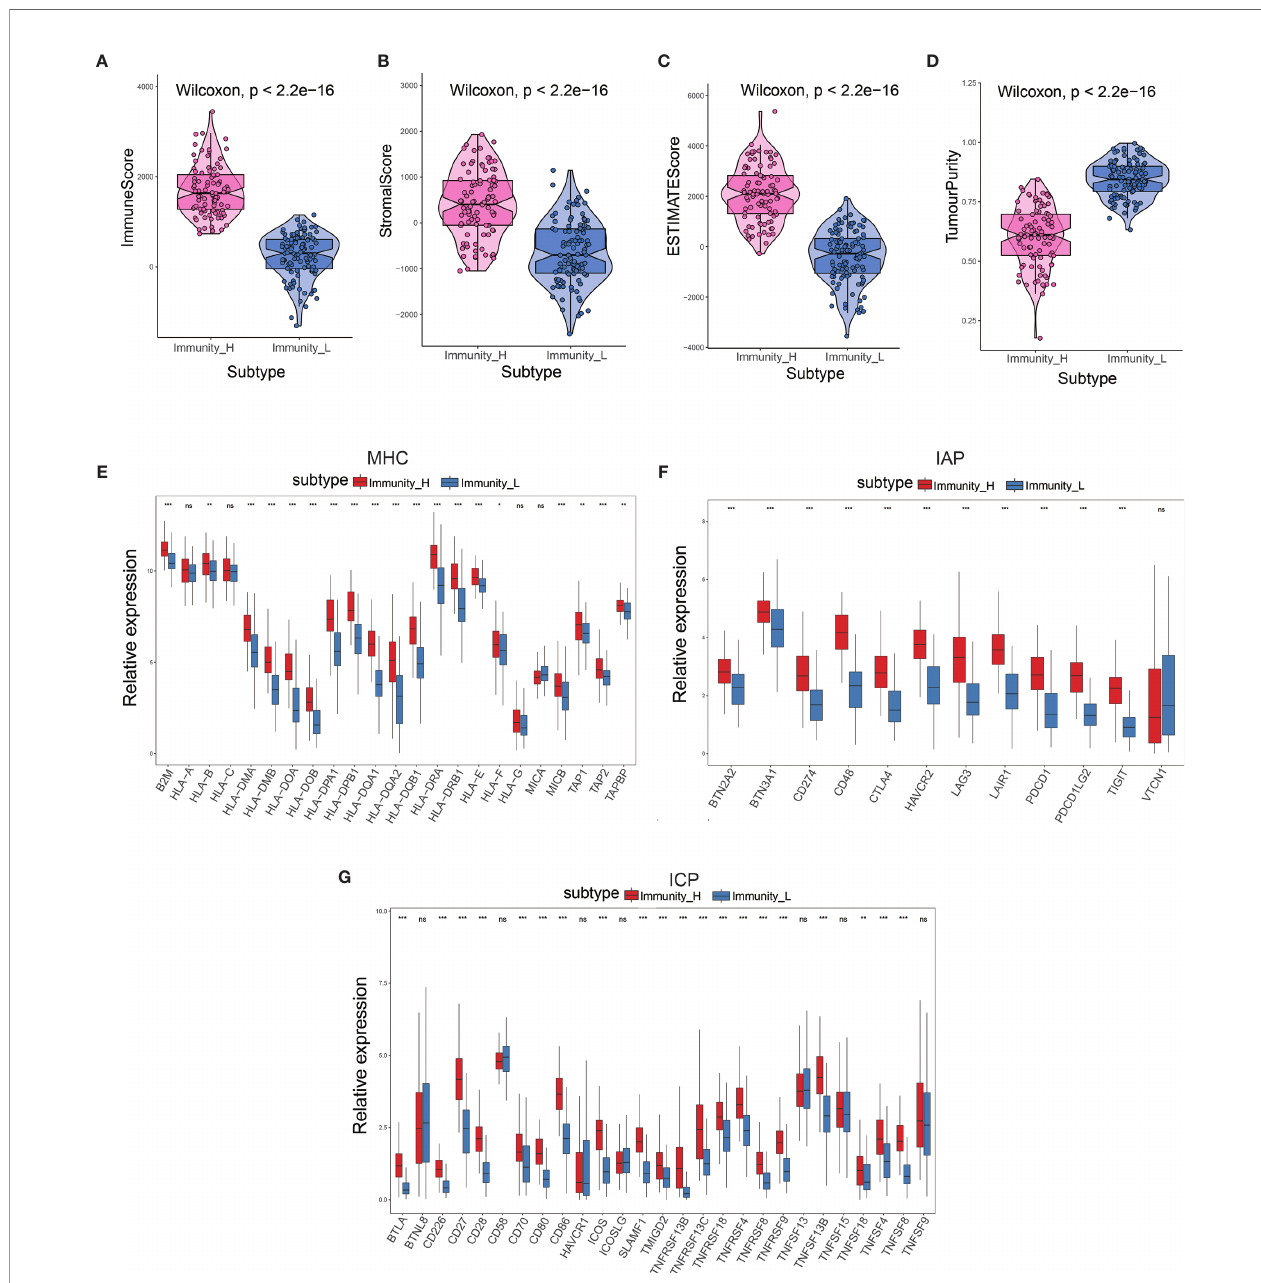
FIGURE 2 | Validation of the effectiveness of immune subtypes. (A – D) The boxplot showed that there was a statistical difference in Immune Score, Stromal Score, ESTIMATE Score, and Tumor Purity between the two immune in fi ltration subtypes (P<2.2e-16). (E – G) The gene expression level of the gene set, including major histocompatibility complex (MHC), immune co-inhibitor checkpoints (IAP), and immune co-stimulator checkpoints (ICP) were all signi fi cantly different in the two immune in fi ltration subtypes